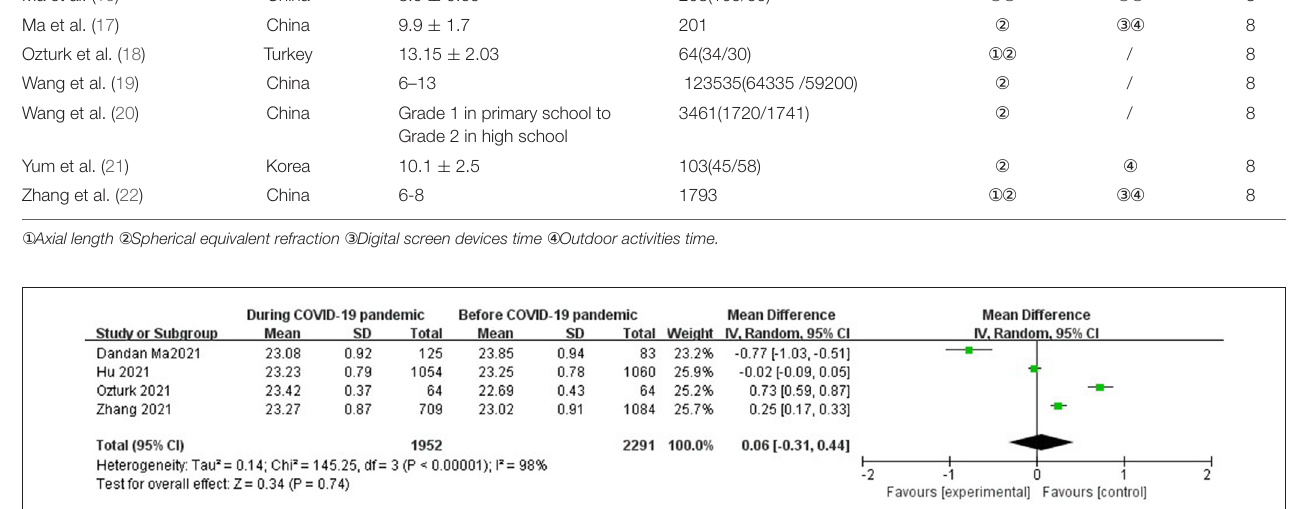
the heterogeneity disappeared (I 2 = 0%, P = 0.49) ( Figure 4B